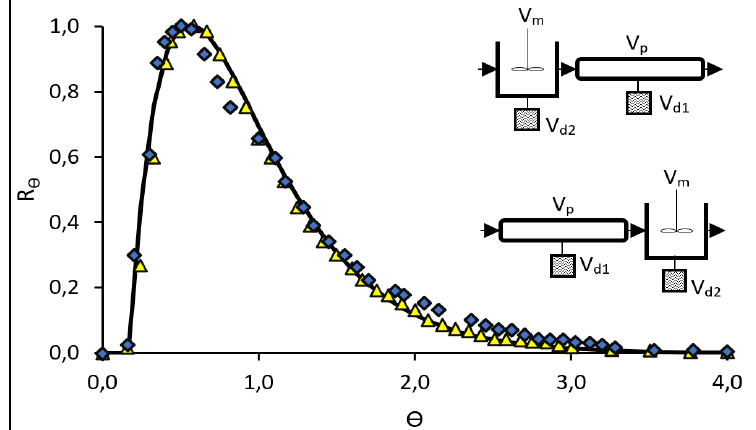
Figure 4: RTD curve for the RTA - RT and RT - RTA dispositions respectively, with R 2 = 0.98, being (Δ), (◊) the experimental data of the dispositions tested respectively, and (-) the proposed model. Source: Authors, (2020).